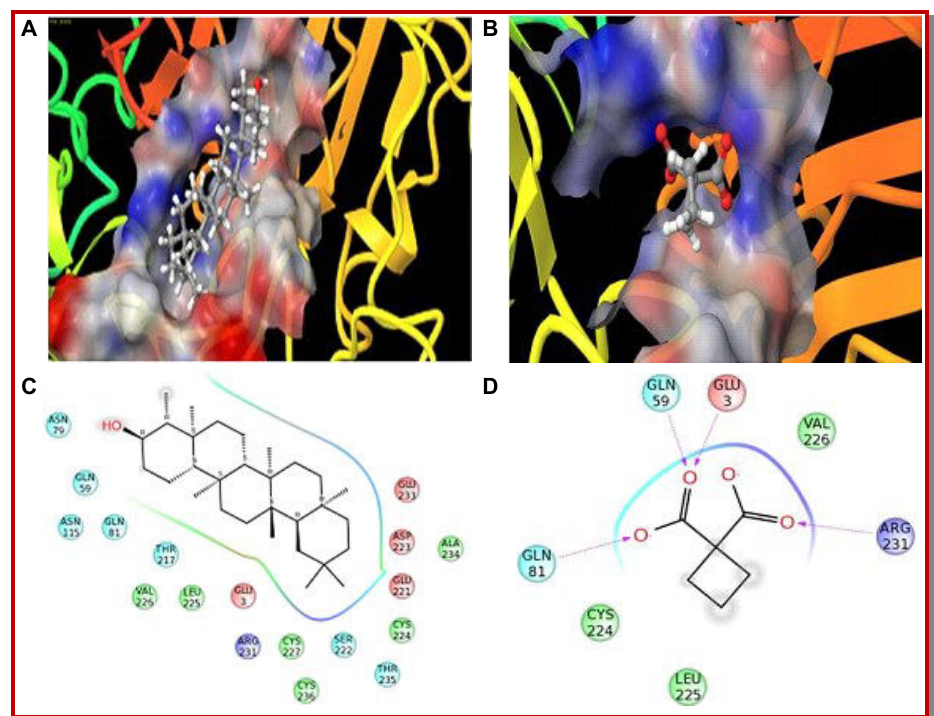
Figure 3: Docking complexes of EGFR protein with (A) epifriedelanol and (B) carboplatin generated by using Glide-XP module of Schrodinger suite are shown in this figure. The proteins, ligands and binding pockets are represented in ribbon, sticks and surface models, respectively. Residues of the EGFR that are within 4 Å proximities to the (C) epifriedelanol and (D) carboplatin are illus- trated in 2D graphics. Dotted lines denote ‘Hydrogen bonds’ between the corresponding